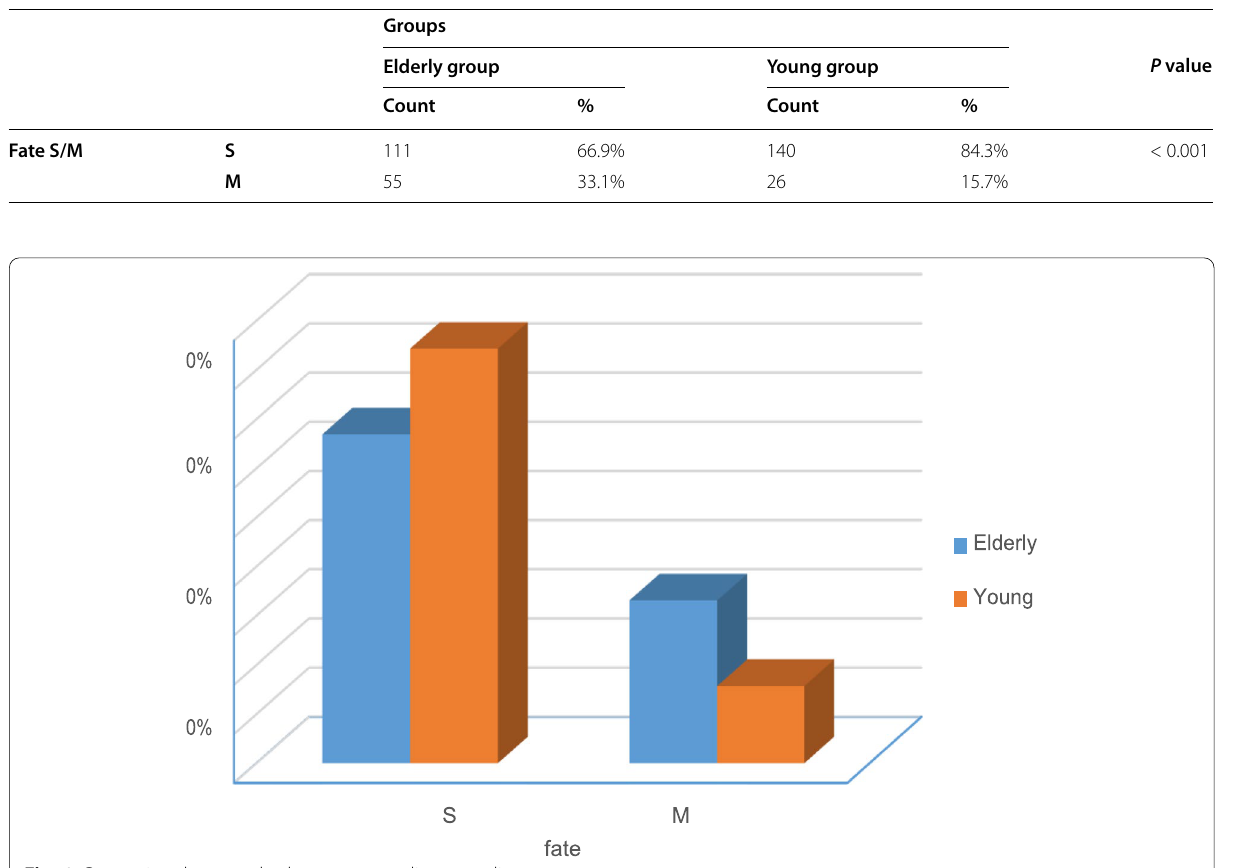
Fig. 6 Comparison between both groups regarding